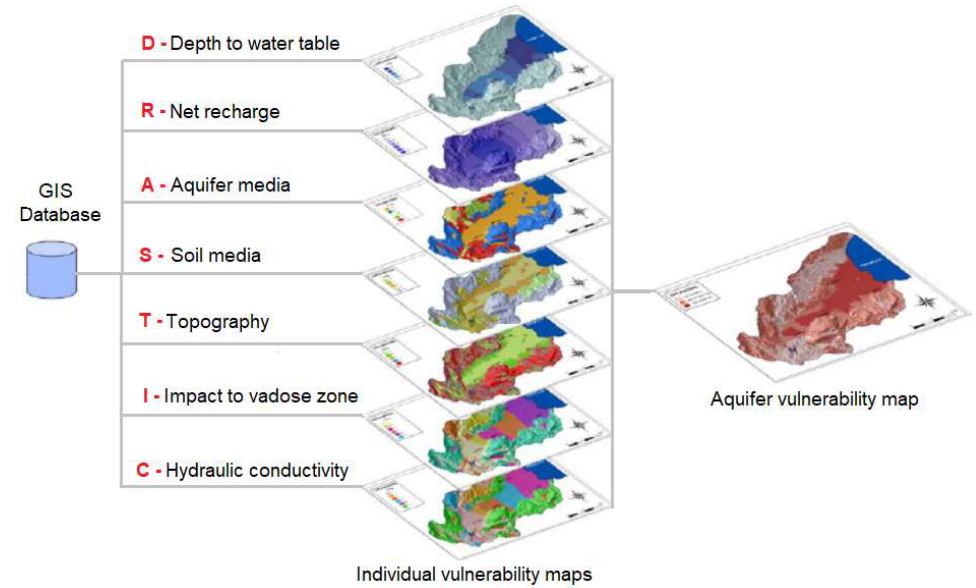
Figure 1. Flowchart for building a vulnerability map in DRASTIC (adapted from [61]).